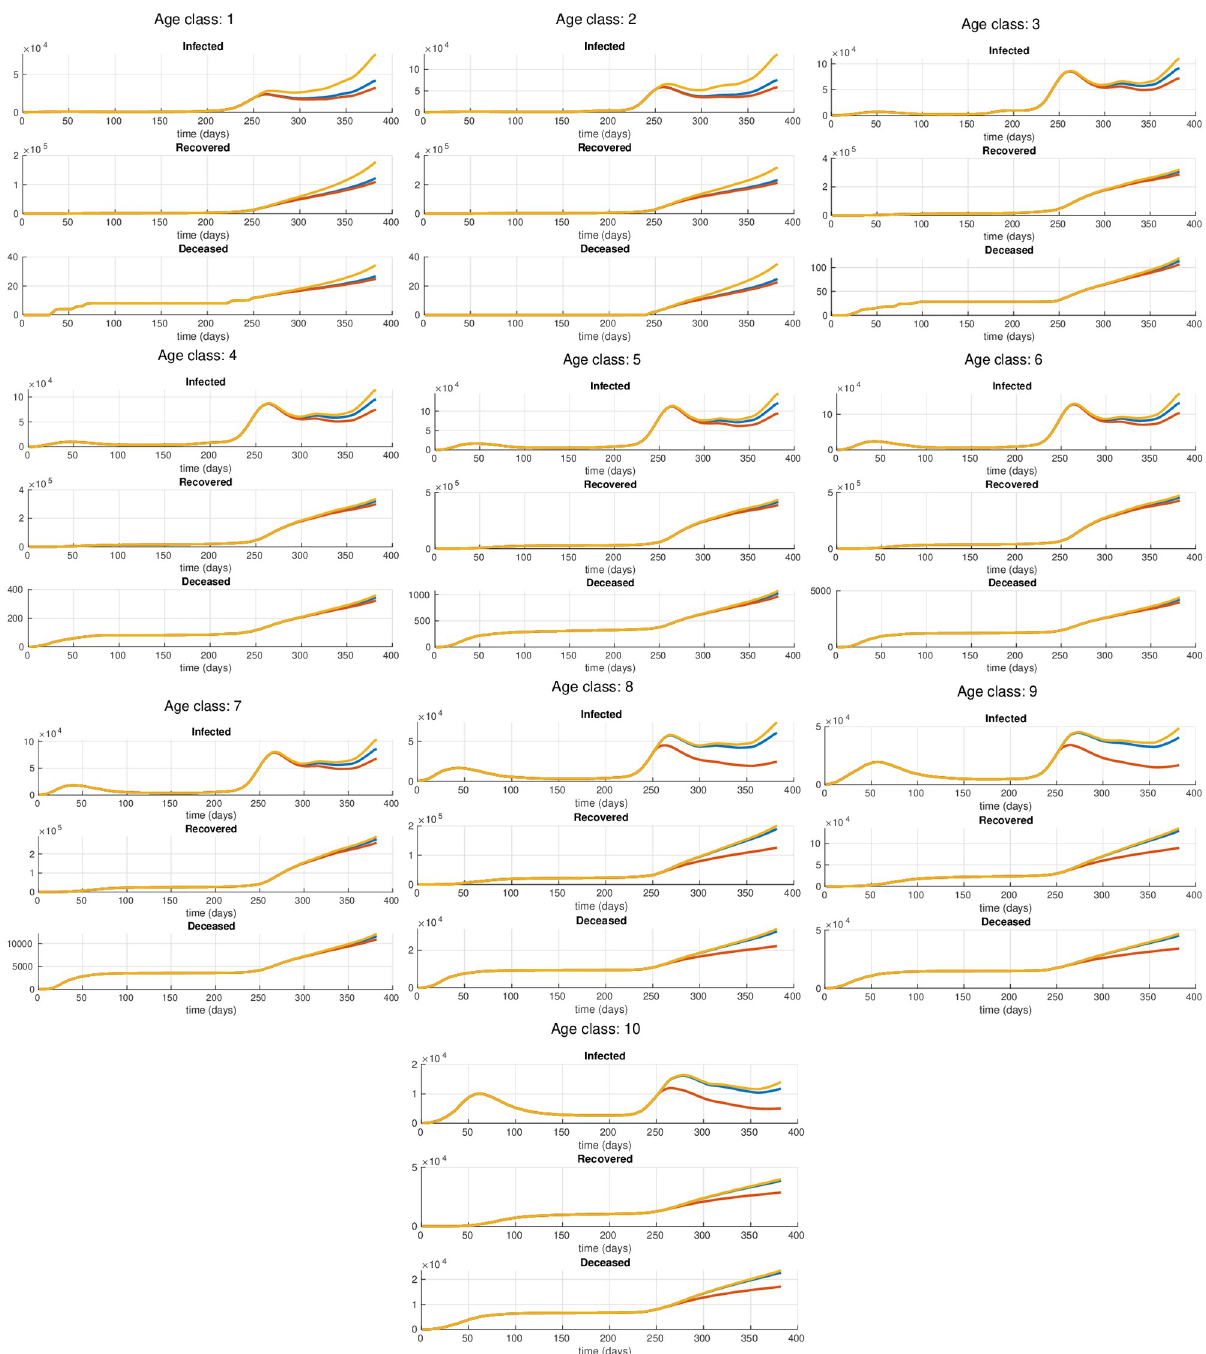
Fig 5. Per-class multi-simulation prediction. The blue curve corresponds to the case of a uniform lockdown obtained using the parameters � θ � estimated from the actual data, the red curve corresponds to the case of a strengthened lockdown for the eldest age classes, and the yellow curve corresponds to the case of a relaxed lockdown for the youngest age classes. The selective restrictions start at day 250.